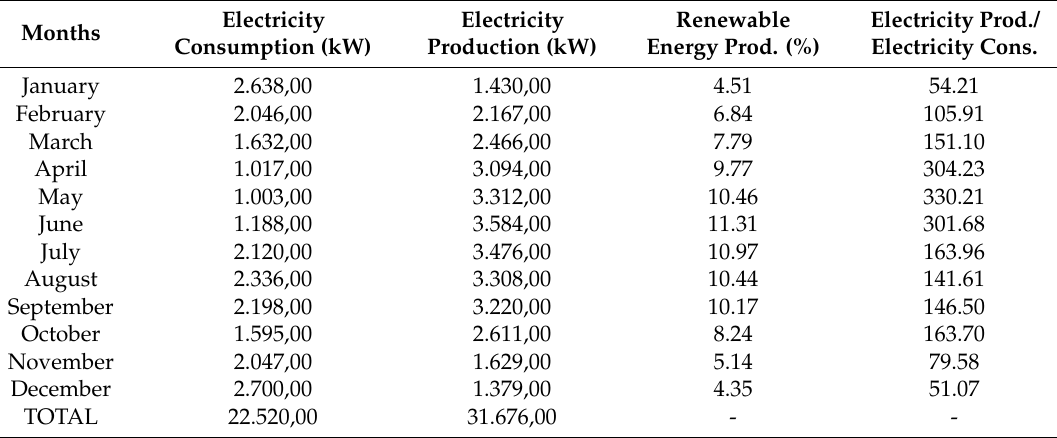
5 shows the effect of sunshine duration on electricity production and consumption. Table 5. Amount of energy consumed and produced monthly by PV panels in Gaziantep Green House Project (2017) [27].